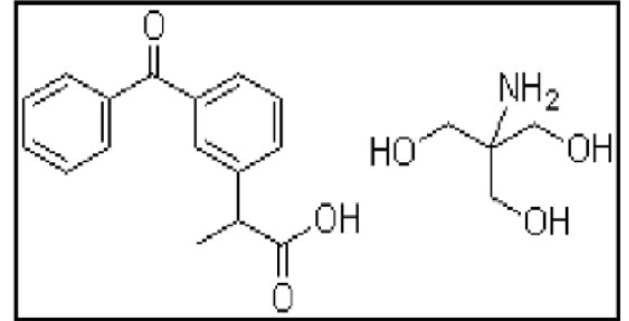
FIGURE 1 - The chemical structure of dexketoprofen trometamol.